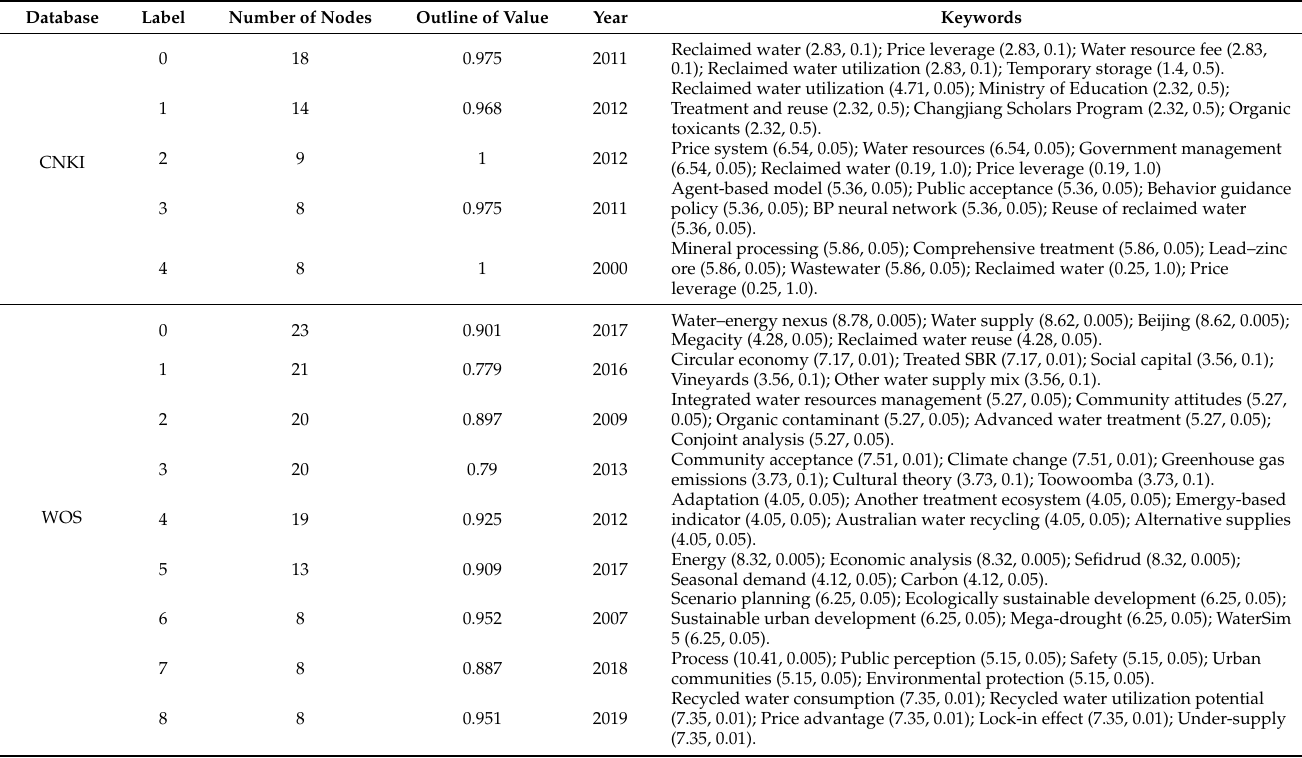
Figure 11. WOS keyword clustering. Table 5. Clustering summary and